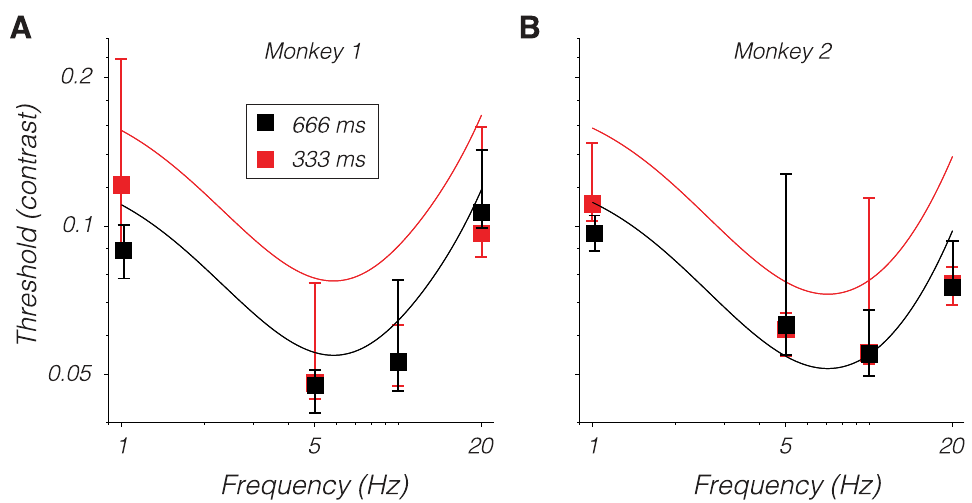
Fig 7. Behavioral detection thresholds from monkey 1 (A) and monkey 2 (B) for stimulus presentations lasting 666 ms (black) and 333 ms (red). Symbols are medians, and error bars span 25th to 75th percentiles. Black curves are predicted thresholds from the model in [27], which is based on a 666-ms presentation time. The red curve is identical to the black ffiffiffi p curve but shifted up by 2 to represent the threshold expected under perfect integration given a 333-ms stimulus duration. Stimuli in these experiments were presented at 5˚ on the horizontal meridian. Data are available at https:// github.com/horwitzlab/LGN-temporal-contrast-sensitivity/blob/master/DataByFigure.xlsx.